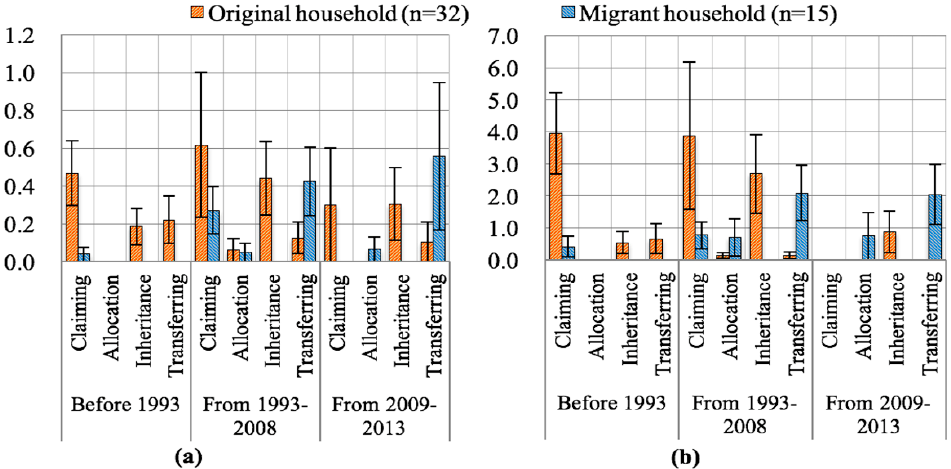
Figure 8. ( a ) Average paddy area obtained by sample households; ( b ) Average upland agricultural area obtained by sample households (Units: hectares per household).